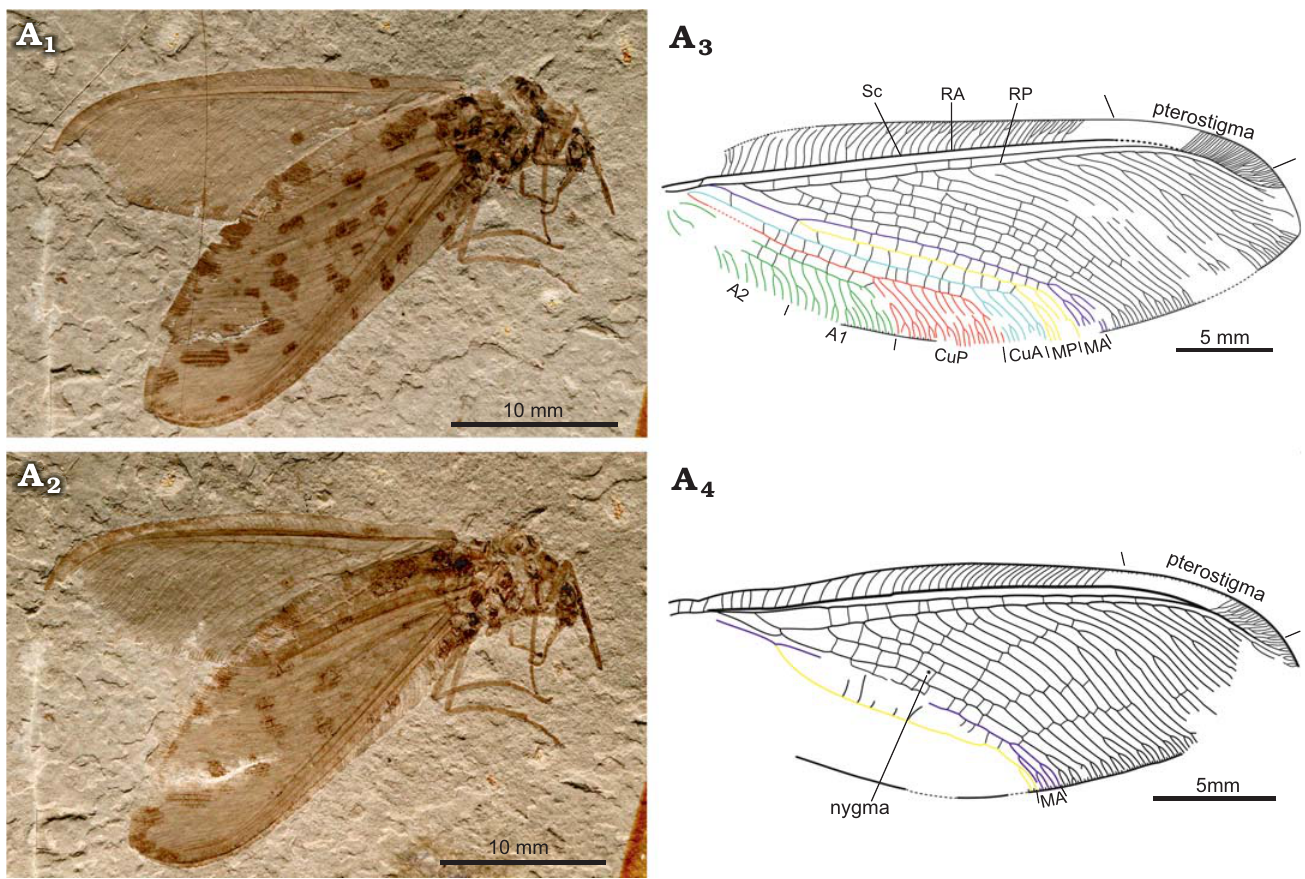
Fig. 2. Lance lacewing Vetosmylus maculosus gen. et sp. nov. (holotype, CNU − NEU − NN2019002P/C) from Aalenian–Bajocian boundary (Middle Jurassic) of Jiulongshan Formation of Daohugou, China. Photographs of part (A 1 ) and counterpart (A 2 ). Line drawings of forewing (A 3 ), hind wing (A 4 ). Abbreviations: A, anal veins; CuA/P, anterior/posterior cubitus; MA/P, anterior/posterior branch of media; RA/P, anterior/posterior branch of radius; Sc,